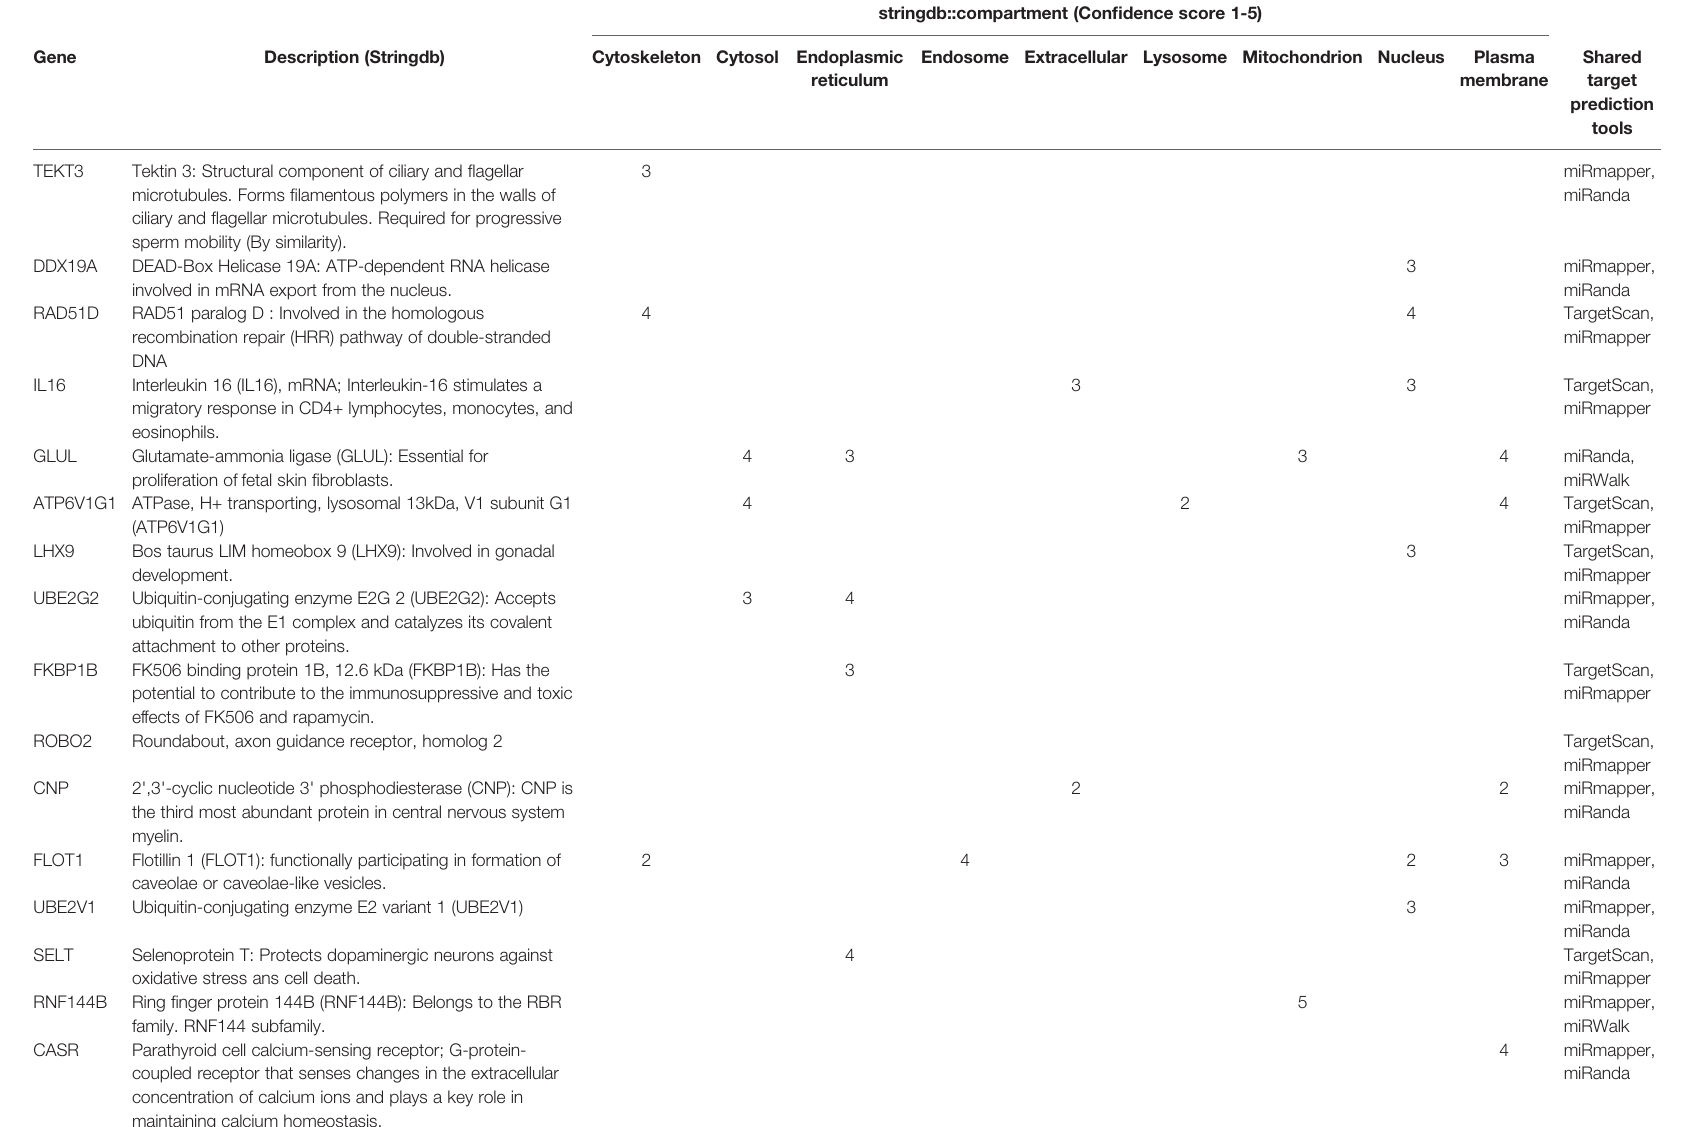
TABLE 3 | Target genes of Mother SEC DE miRNAs intersected by four target prediction tools and the 16 target gene interactions generated by compartment analysis in StringDB. stringdb::compartment (Con fi dence score